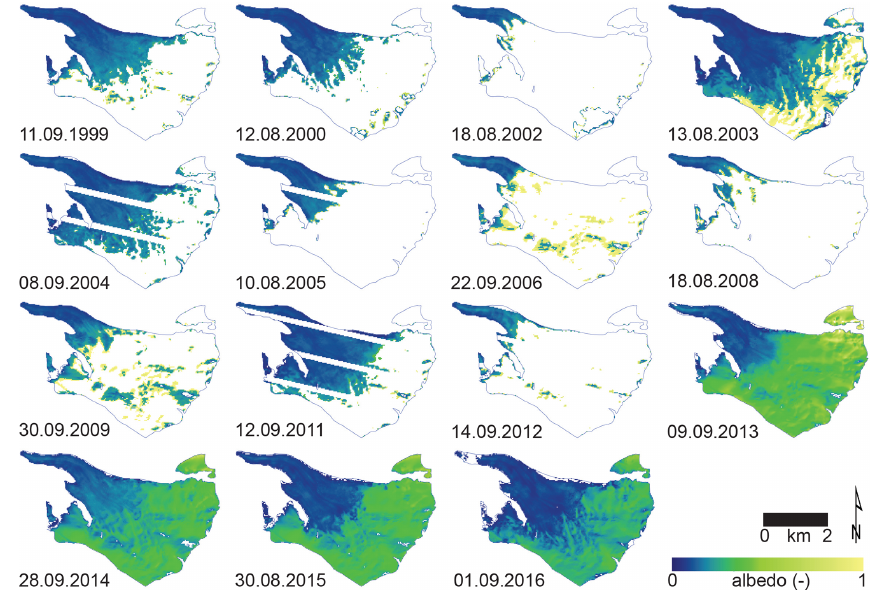
Figure 3. Spatio-temporal evolution of shortwave broadband albedo between 1999 and 2016 for Findelengletscher.